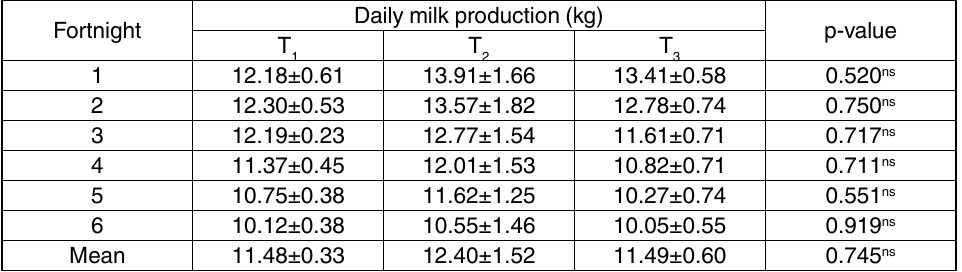
Table 3. Fortnightly average milk production 1 of lactating cows maintained on three experimental rations, kg Fortnight